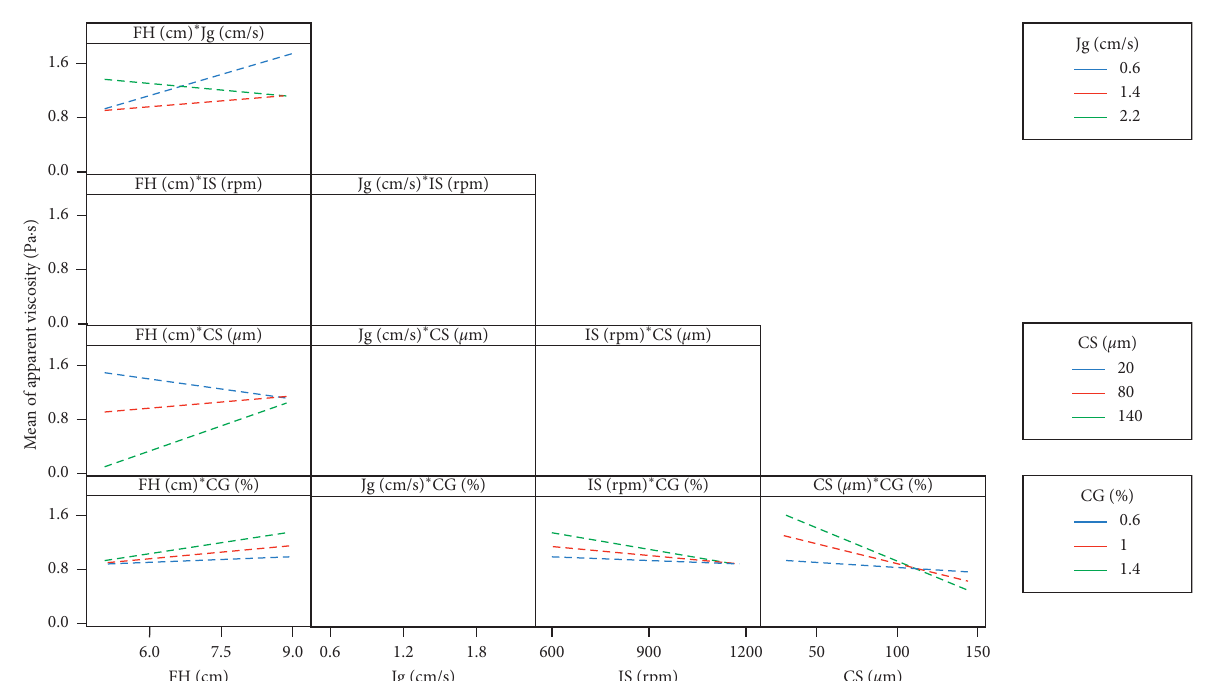
Figure 10: Interactions between flotation variables in determining froth rheology (after